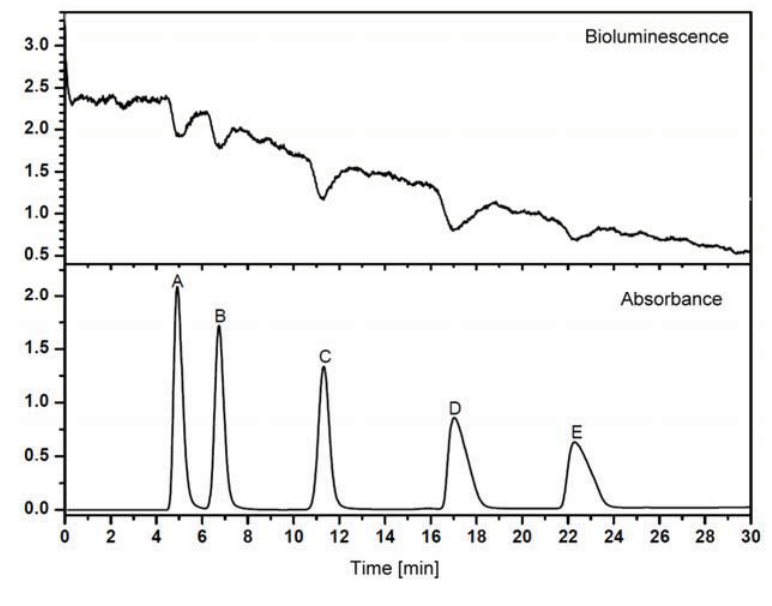
Figure 6. Effect-related analysis with Bioluminescence Inhibition Detector (BID, upper trace) and Photodiode Array Detector (PDA, lower trace). (A): 2,4-dinitrophenol (200 mg/L); (B): 4-fluoro-2-nitrophenol (300 mg/L); (C): 2-methyl-4,6-dinitrophenol (200 mg/L); (D): 3,4-dichlorphenol (300 mg/L); (E): 3,5-dichlorphenol (300 mg/L). Please note the decreasing baseline of the bioluminescence, most likely caused by the water/methanol gradient. In addition, the relative poor sensitivity has to be considered, which might be due to the insufficient incubation time in the online system (see “Challenges” below). Figure courtesy of Philipp Stolper, modified